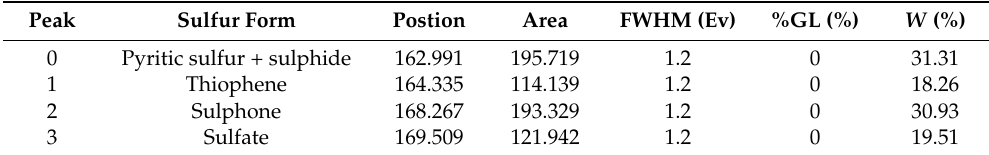
Table 3. The S 2p spectrum analysis of the XF oxidized coal